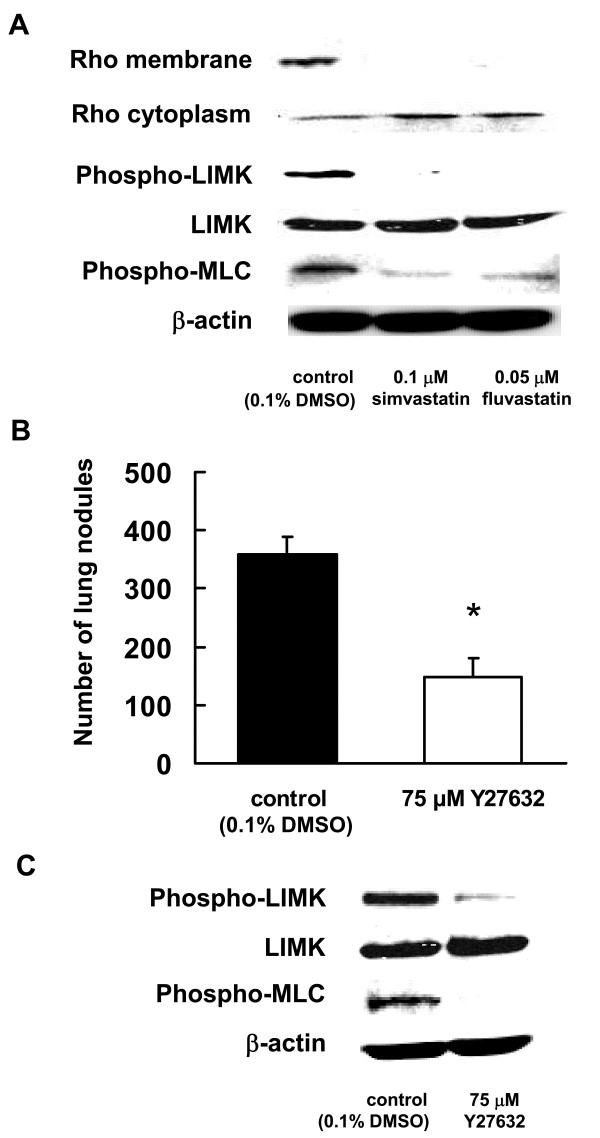
Statins specifically suppress the Rho/ROCK pathway. (A) B16BL6 cells were treated with 0.05 μM fluvastatin or 0.1 μM simvastatin for 3 d. Rho expression was determined by immunoblotting analysis of the membrane and cytoplasmic fractions by using the anti-Rho antibody. The expression of phosphorylated LIMK and MLC was determined by immunoblotting analysis of the whole-cell lysate using phosphorylated LIMK (phospho-LIMK) and phosphorylated MLC (phospho-MLC). (B) B16BL6 cells, which had been treated with 75 μM Y27632 for 3 d, were injected into the tail veins of syngeneic C57BL/6J mice. After 14 d, visible nodules that metastasized to the lung were counted. The results are expressed as the means ± S.D. of 9 mice. (C) B16BL6 cells were treated with 75 μM Y27632 for 3 d. The expression of phosphorylated LIMK and MLC was determined by immunoblotting analysis of the whole-cell lysate using phosphorylated LIMK (phospho-LIMK), phosphorylated MLC (phospho-MLC), and β-actin (internal standard).